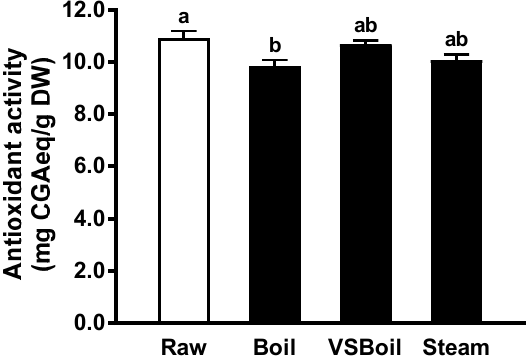
Figure 2. Free radical scavenging activity of raw and cooked purple potato (PP) extract. DW: dry weight; VSBoil: vacuum-seal boiling. a,b means among bars without common letters differ significantly at p < 0.05 (mean ± SEM, n = 3).